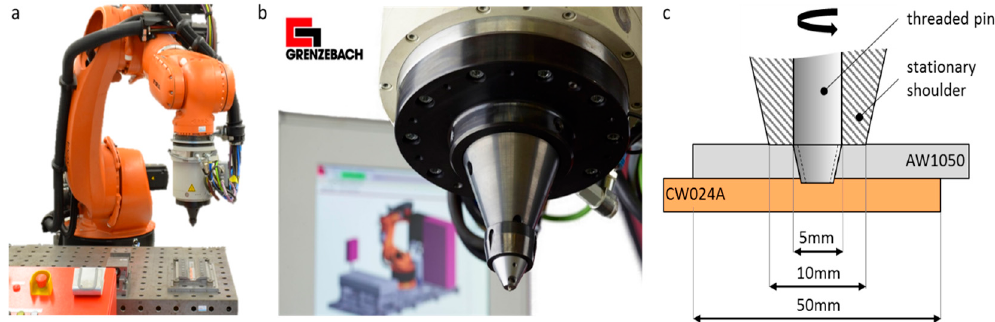
Figure 1. Process setup: ( a ) Robotic friction stir welding (FSW) system (Grenzebach); ( b ) Stationary shoulder tool; ( c ) Schematic illustration of the tool and joint configuration.